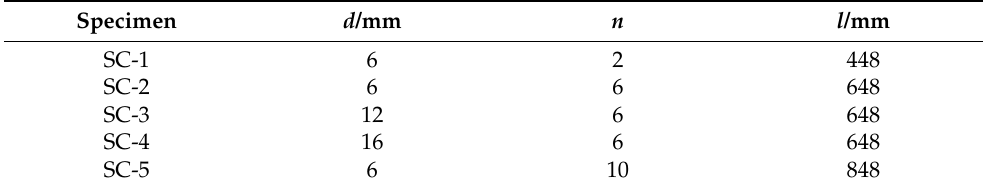
Table 1. Summary of the test specimens.